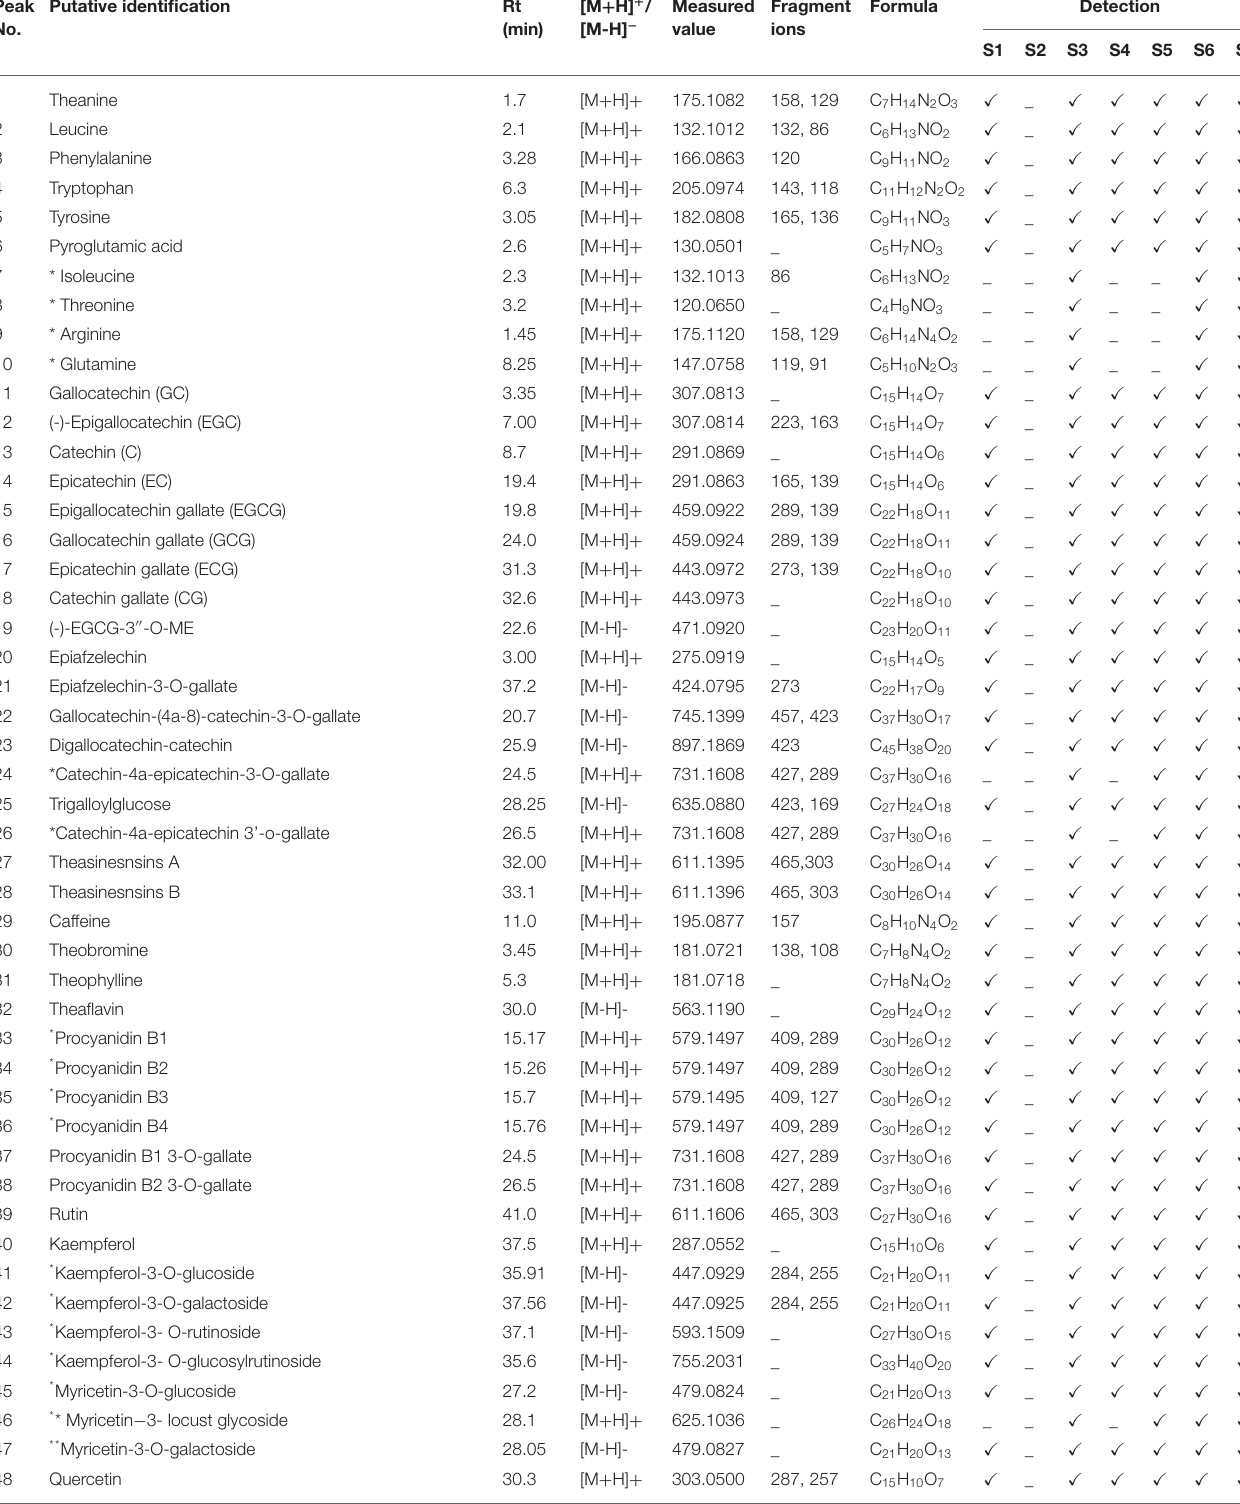
TABLE 2 | List of the identified components in tested samples. Peak